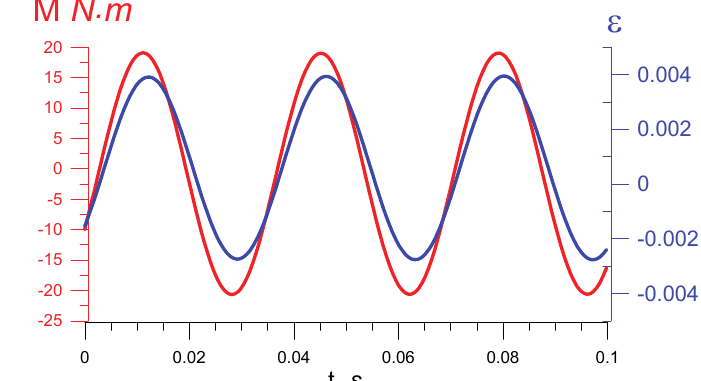
Figure 6: Registered moment and strains